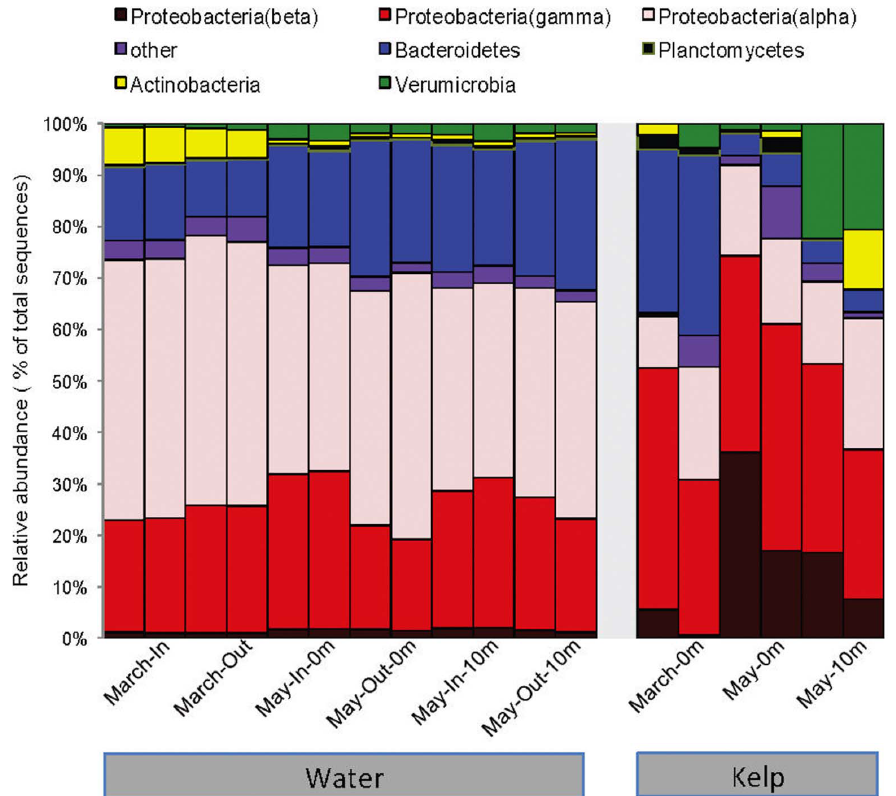
Figure 1. Kelp surface and seawater bacterial communities at the level of phyla. ‘‘Kelp’’ refers to the kelp surface samples; ‘‘Water-In’’ refers to the seawater samples adjacent to the kelp sampled; ‘‘Water-Out’’ refers to the seawater sampled outside the perimeter of the kelp forest.